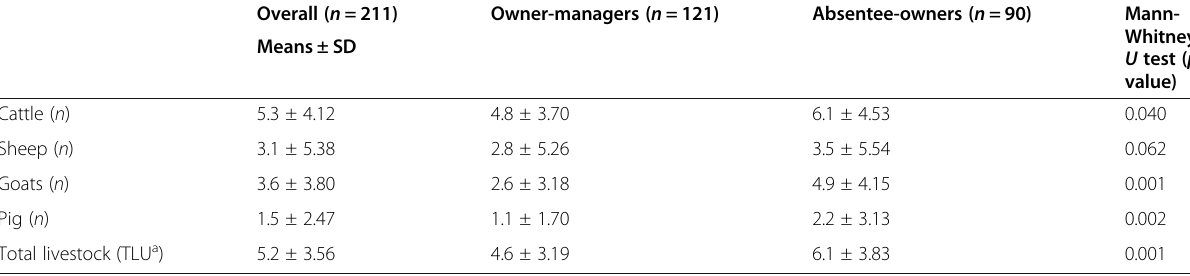
Table 3 Number of cattle and other animal species per type of owner